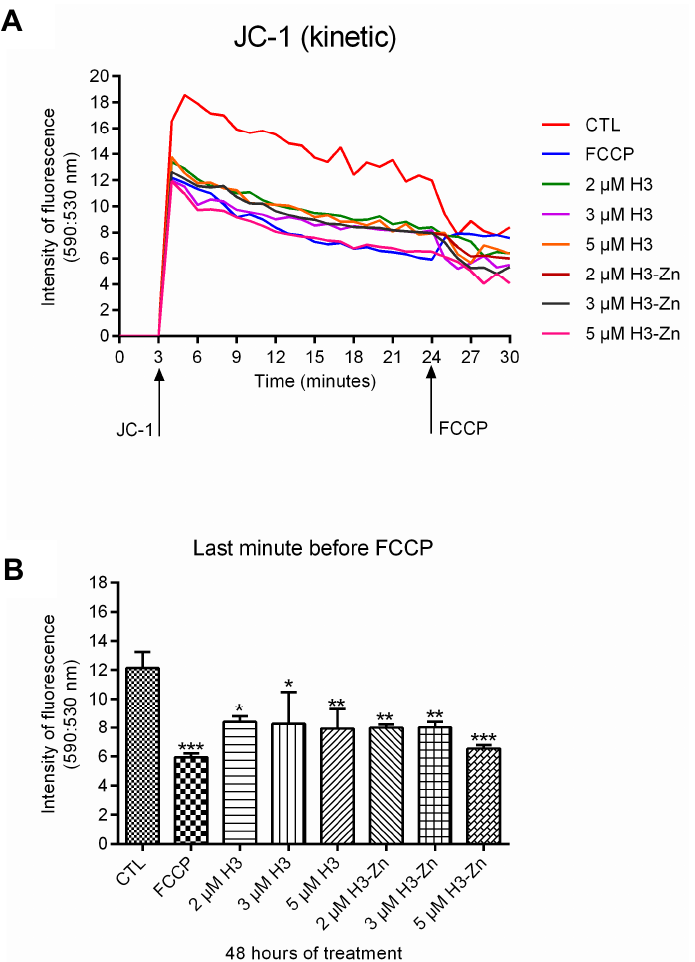
Figure 7. Effects of the H3 and Zn- H3 on the mitochondrial function of Leishmania amazonensis promastigotes using the JC-1 marker. ( A ) Values of ∆Ψ m were evaluated for 30 min, after which the uncoupler FCCP was added to collapse the mitochondrial membrane potential. Parasites grown in different concentrations of H3 and Zn- H3 for 48 h were analyzed. ( B ) The effect of FCCP (1 µ M) in the ∆Ψ m was also evaluated. Fluorescence intensity is expressed as arbitrary units (A.U.). The experiments were performed three times in triplicate, and the figures shown represent these experiments. One-way ANOVA with Dunnett’s post hoc test was used for statistical analysis. * p < 0.05; ** p < 0.0; *** p < 0.001.